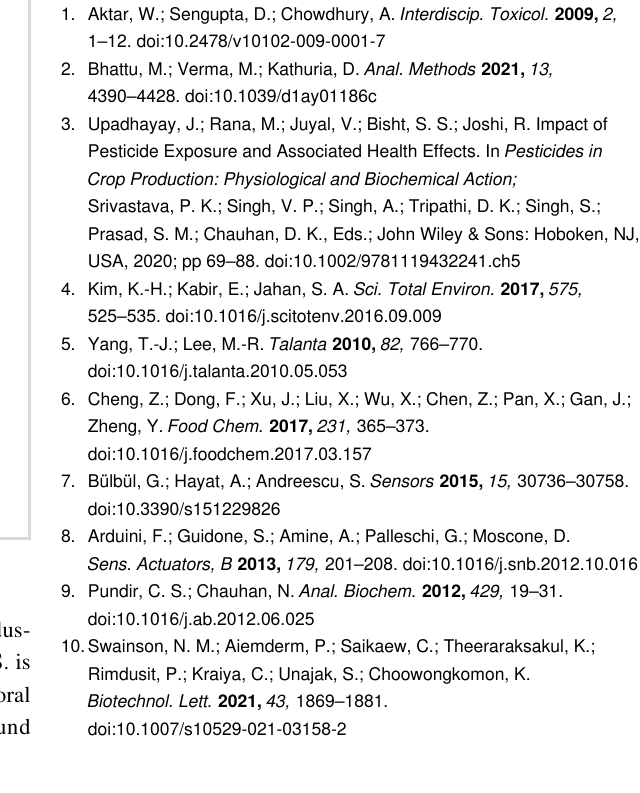
Table S1: Chemical sample table indicating corresponding CAS, supplier and other details. Table S2: Experimental sample table for composition analysis using binding energies of GO and RGO by XPS. Table S3: Experimental sample table for the modified glassy carbon electrode electrochemical characteristics. Figure S1: CV of ERGO/GCE at different scan rates (10–300 mV/s) in 1.0 Storage stability of the proposed sensing matrix groundwater. Figure S3: (A) Absorption spectra of parathion and (B) corresponding calibration